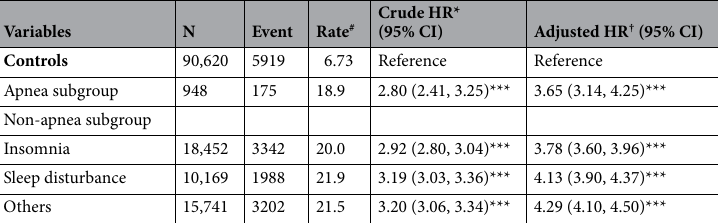
Table 3. Incidence rates and hazard ratios for dyspepsia by subtypes of sleep disorders. Rate # , incidence rate, per 1,000 person-years; Crude HR*, relative hazard ratio. Adjusted HR † : multivariate analysis including same covariates as Table